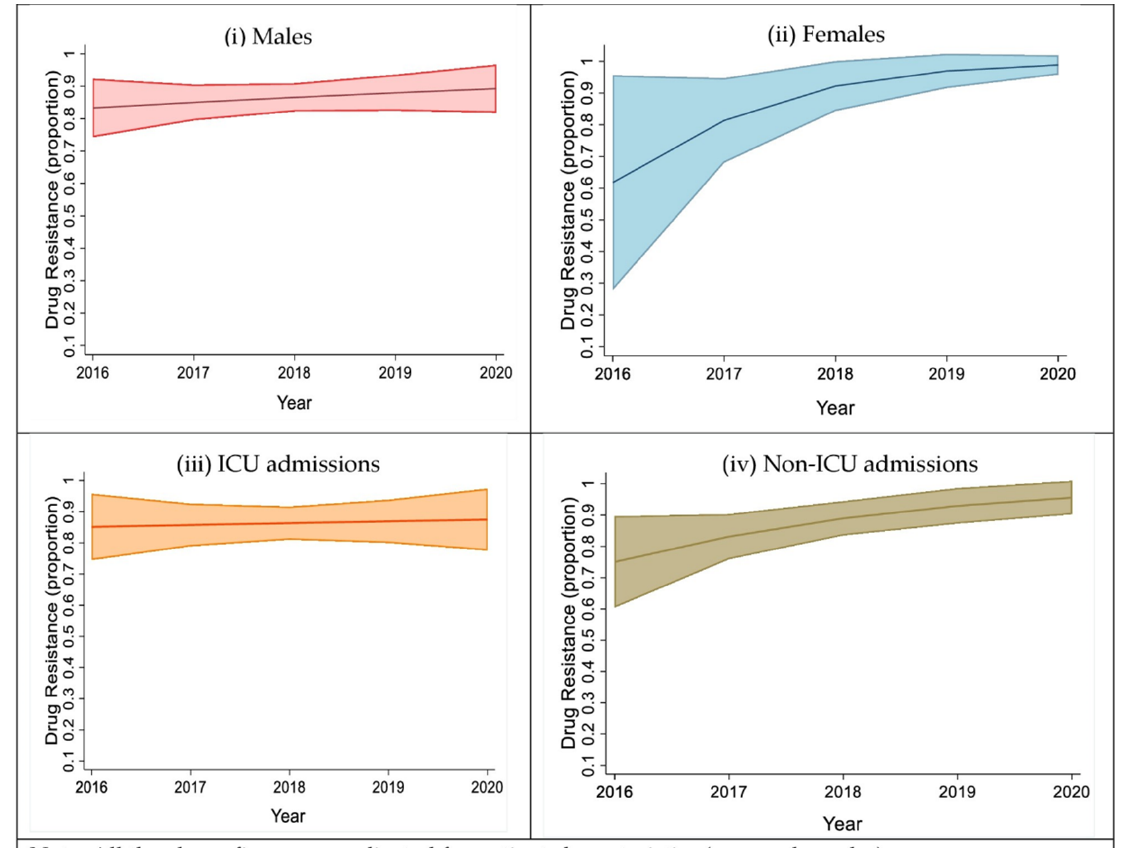
Figure 4. ( i ) shows the overall drug resistance in the top five organisms isolated from males, from the year 2016 to 2020; ( ii ) shows the overall drug resistance in the top five organisms isolated from females, over five years, a steep increase in the overall drug resistance was observed; ( iii ) shows the overall drug resistance in patients admitted to the ICU, from the year 2016 to 2020, and ( iv ) shows the overall drug resistance in patients admitted to non-ICU wards, from the year 2016 to 2020 and a gradual increase in the drug resistance was observed. (Note: Proportion 0.1 = 10%, 1 =